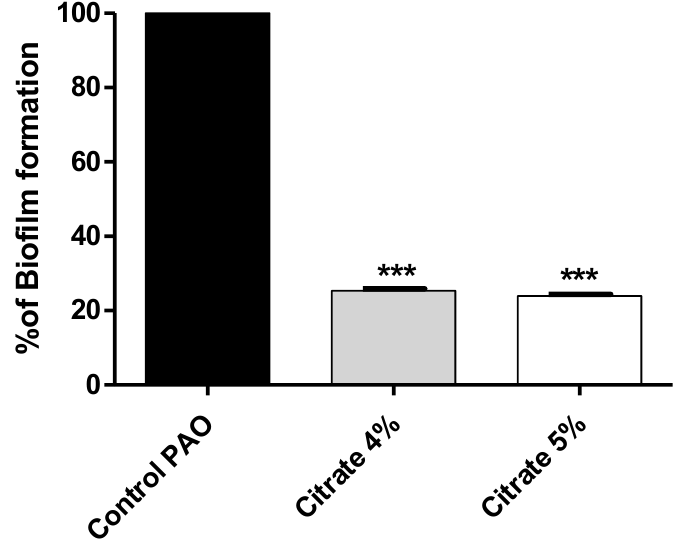
Figure 2. Sodium citrate inhibits biofilm formation in P. aeruginosa . The absorbances of crystal-violet-stained biofilm-forming cells were measured. Sodium citrate in 4% or 5% significantly decreased biofilm formation (*** = p < 0.0001).